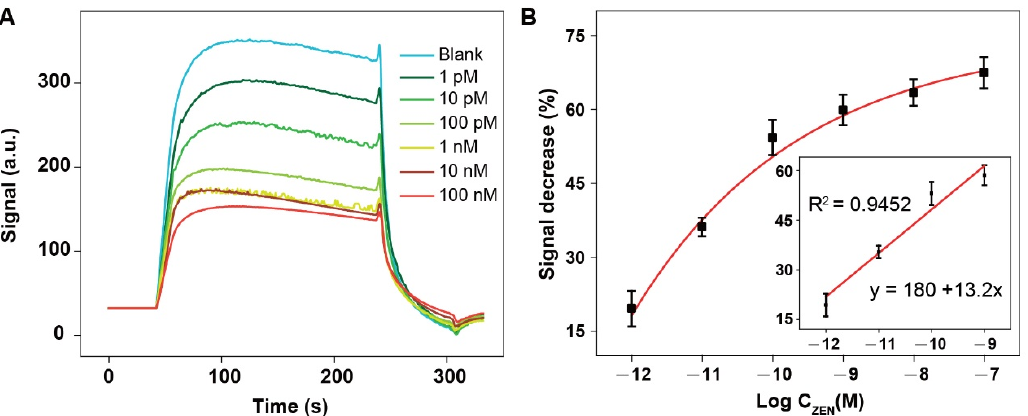
Figure 5. Detection of ZEN in buffer by EWOF aptasensor without Tween 80 coating: ( A ) original response curves for the detection of samples containing ZEN at a wide concentration range; ( B ) the titration curve generated according to the signal decrease percentage (S%). The fluorescence intensities used for the calculation of the S% were indicated in ( A ). The error bars in figure ( B ) are the standard deviations derivatized from the three replicates.